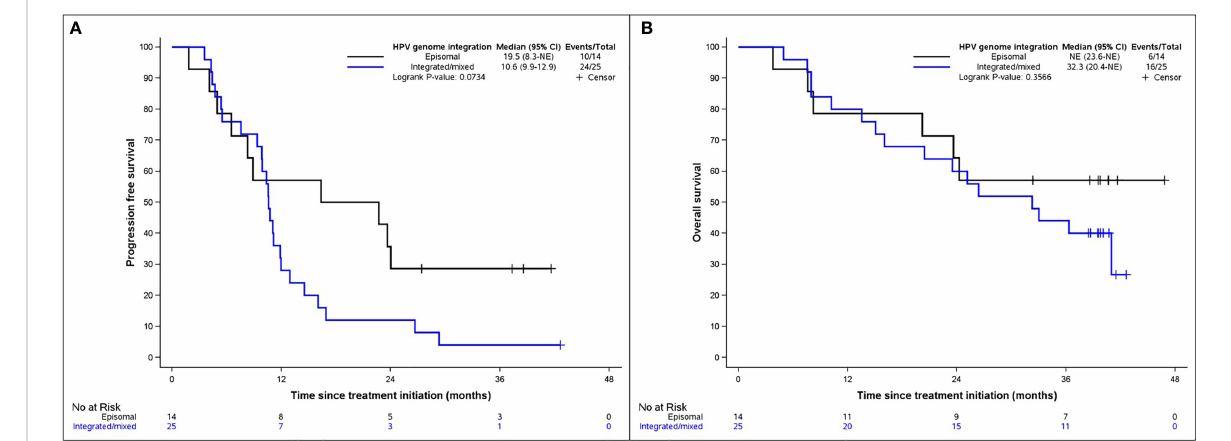
FIGURE 1 Kaplan-Meier diagrams representing (A) PFS and (B) OS according to the integration of HPV genome. Blue line symbolizes integrated/mixed forms, black line episomal